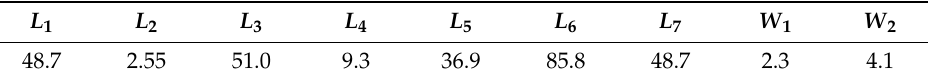
Table 2. Dimensions of the prototype II (unit: mm; referring to Figure 7).